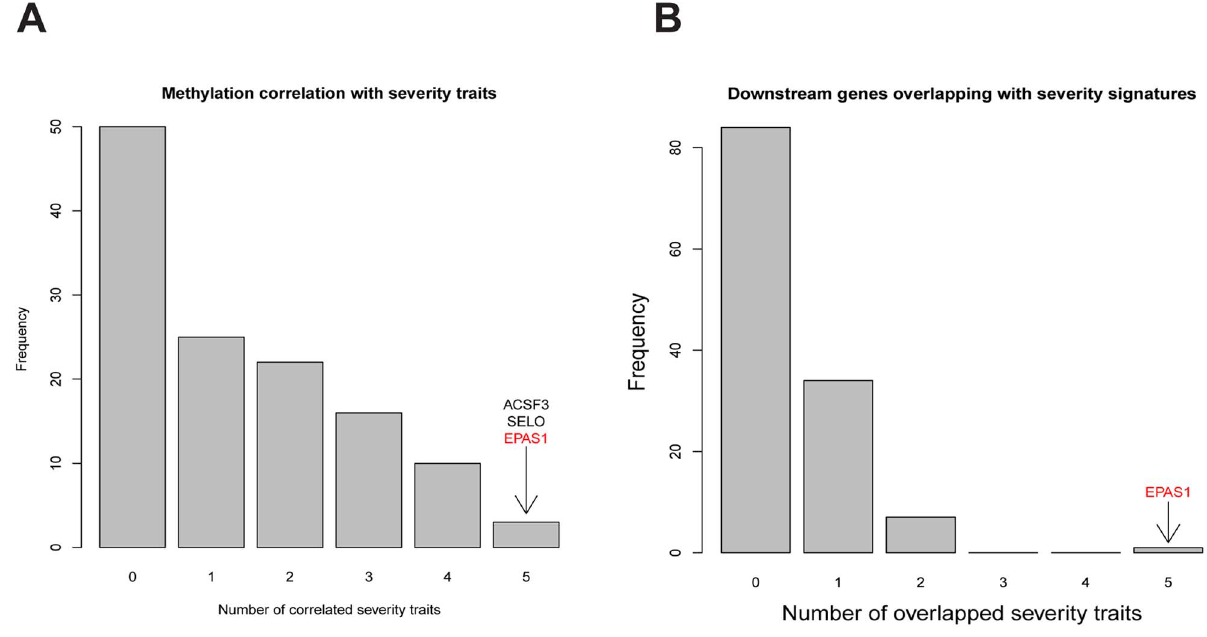
Fig. 4. Comparing characteristics of key regulators with 5 COPD severity related traits in LGRC. A ) Comparing lung DNA methylation profiles of key regulators with 5 COPD severity related traits by Spearman correlation. At the Fisher’s exact test p-value , 0.05, the DNA methylation level variations of 3 key regulators, ACSF3 , SELO , and EPAS1 , were correlated with all 5 COPD severity related traits. B ) Comparing downstream genes of key regulators with gene signature sets for 5 COPD severity related traits by the hypergeometric test. At the Fisher’s exact test p-value , 0.05, only the key regulator EPAS1 ’s downstream genes significantly overlapped with gene signature sets for all 5 COPD severity related traits.